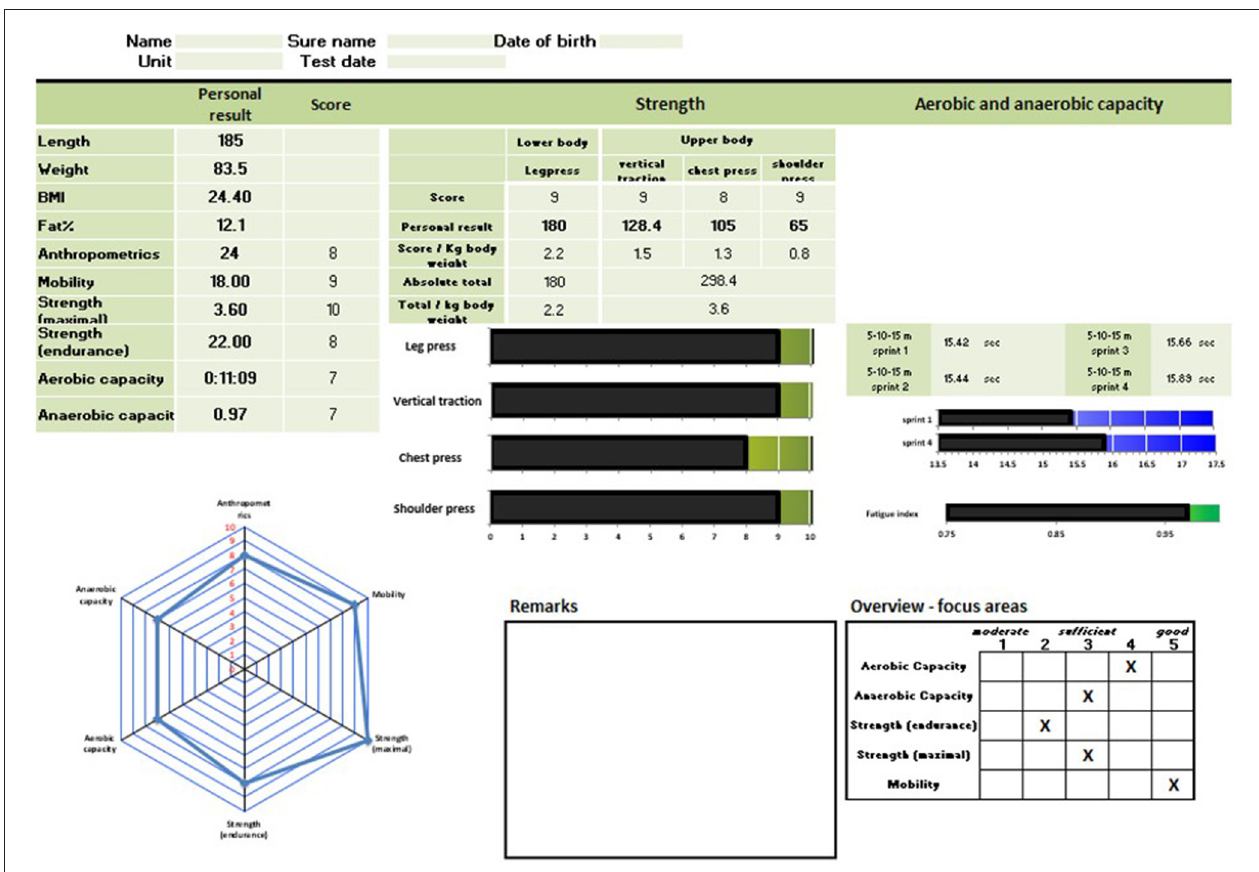
FIGURE 4 | Example of the individual feedback of the physical assessment battery, according to the dimensions described